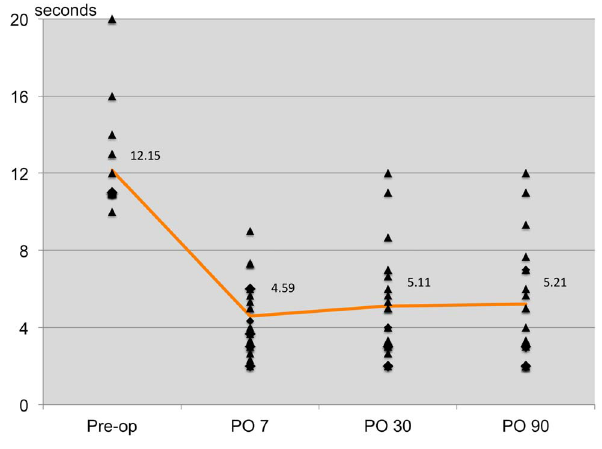
Figure 3. Pattern of post-operative dry eye patients detected by TBUT.